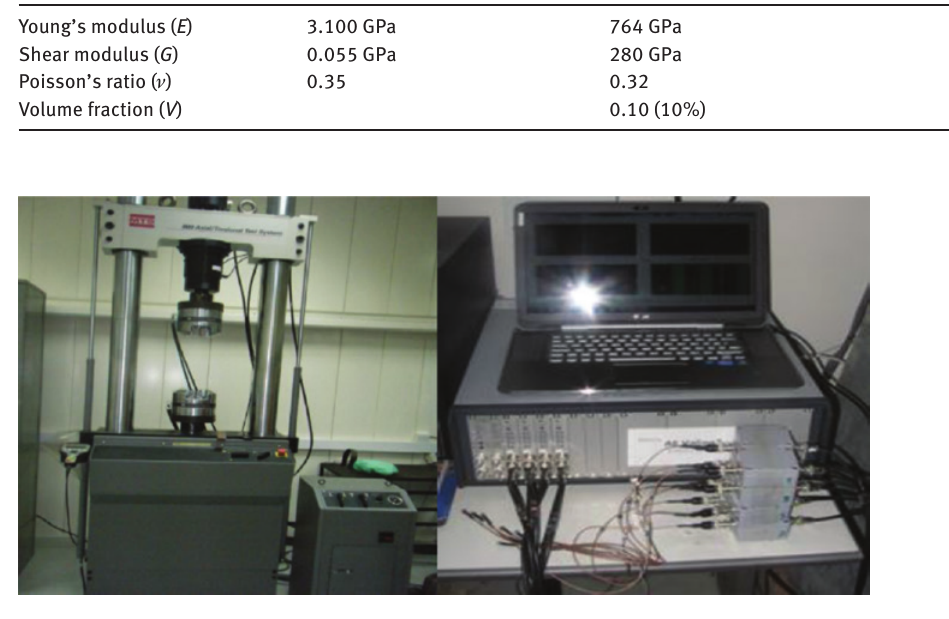
Table 1: Mechanical properties of the components and fillers of GFRPNC. Property